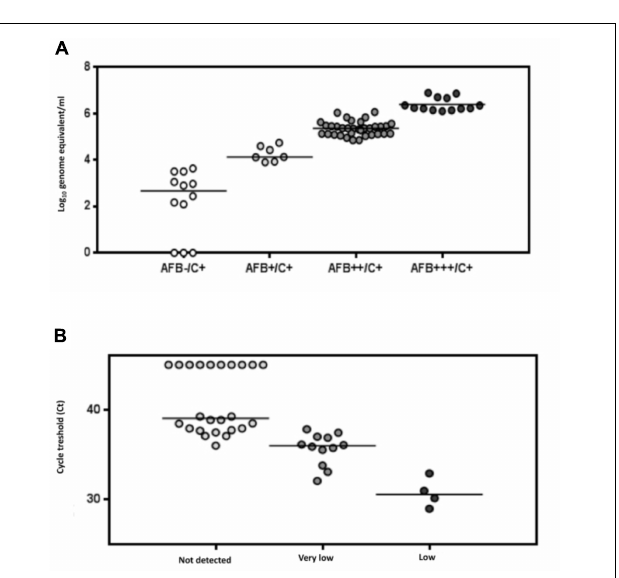
FIGURE 7 | MTB DNA concentration in culture positive samples stratified according to smear microscopy results using the IS6110 PCR (A) . Comparison of real-time PCR IS6110 assay and Xpert MTB/RIF on 40 clinical sputum samples. Positive threshold of the PCR assay is indicated by the dotted line (B)